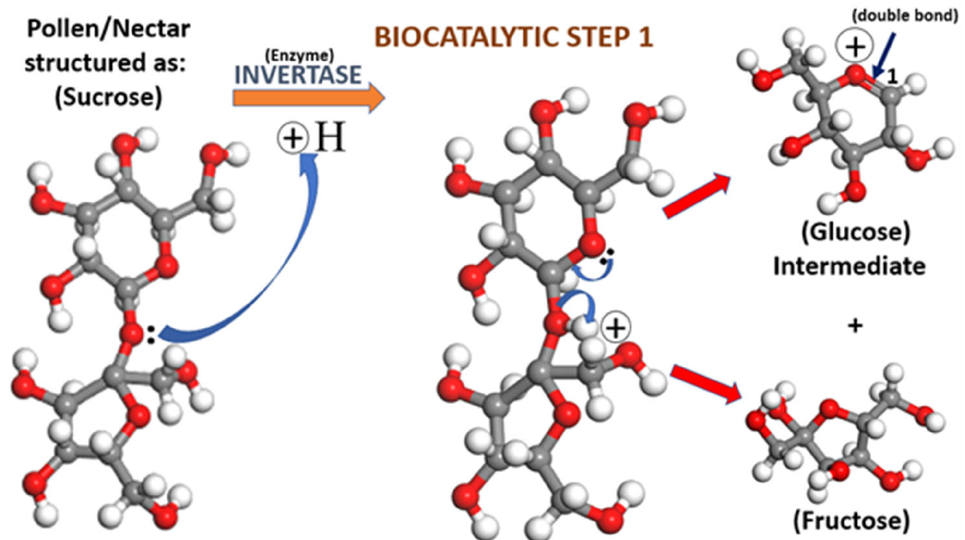
Figure 9. The biocatalytic step 1 conversion of the sucrose molecule (C 12 O 11 H 22 ) contained in nectar and pollen to intermediate glucose (C 6 O 5 H 11 ) and fructose molecules (C 6 H 12 O 6 ). The orange arrow indicates the utilization of the enzyme invertase as the biocatalytic promoter of the reaction. The blue arrows indicate the flow of two electrons that cause bond breakage and reformation. The gray, red, and white spheres represent carbon, oxygen, and hydrogen, respectively. The red arrows indicate the generation of glucose intermediate and fructose molecules after the application of invertase and bond breakage from sucrose.